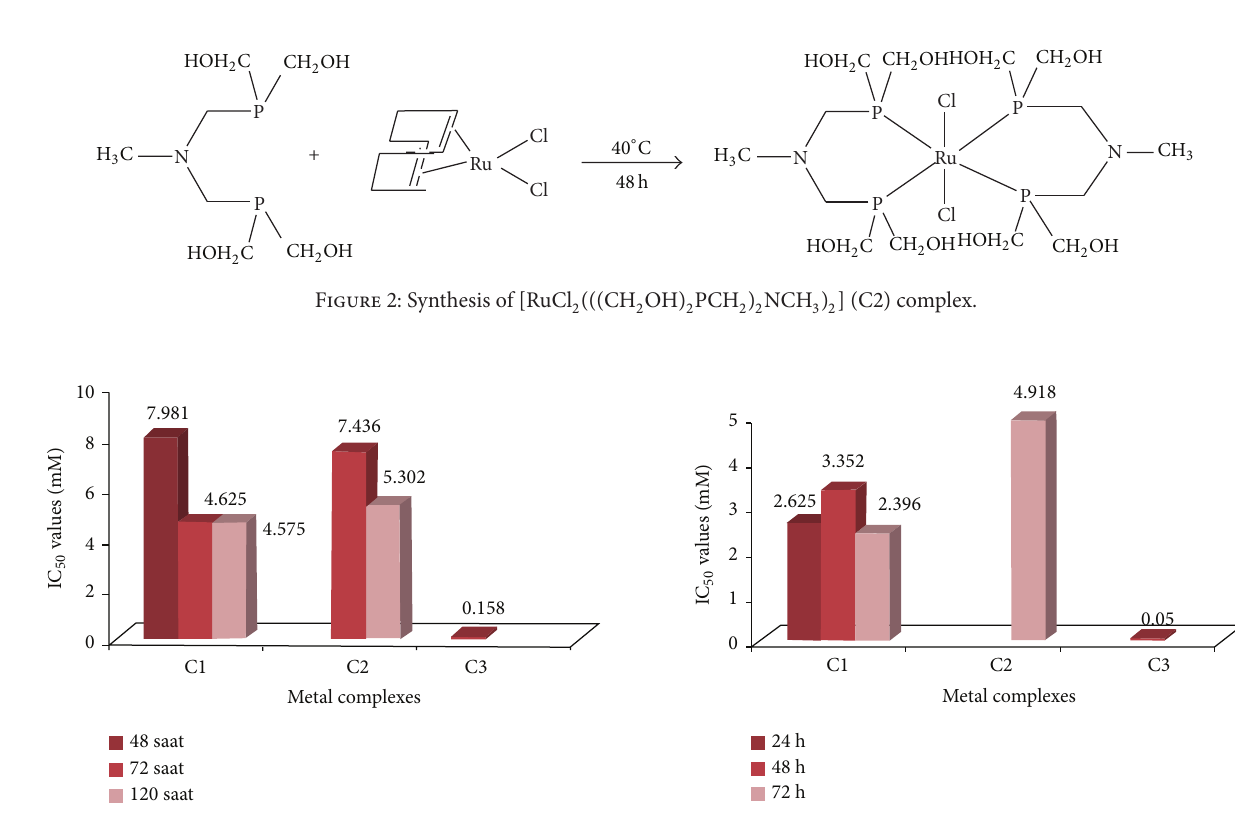
Figure 4: IC 50 values of metal complexes at 24, 48, and 72 h for K562